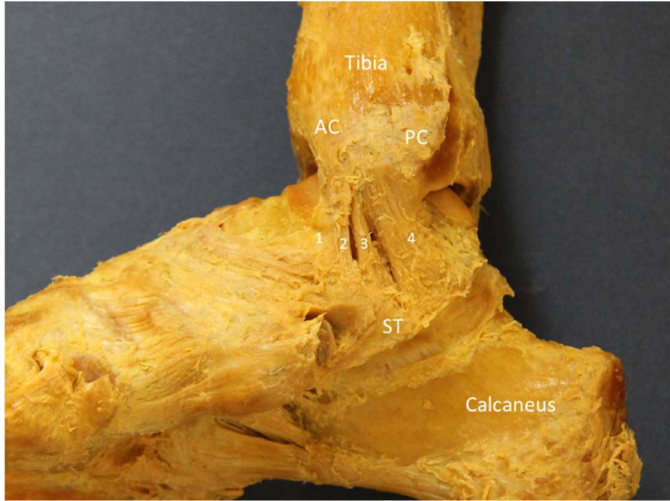
Figure 8. The cadaveric model of the deltoid ligament. 1: tibionavicular ligament; 2: tibiospring ligament; 3: tibiocalcaneal ligament; 4: posterior tibiotalar ligament; AC: anterior colliculus; PC: posterior colliculus; ST: sustentaculum